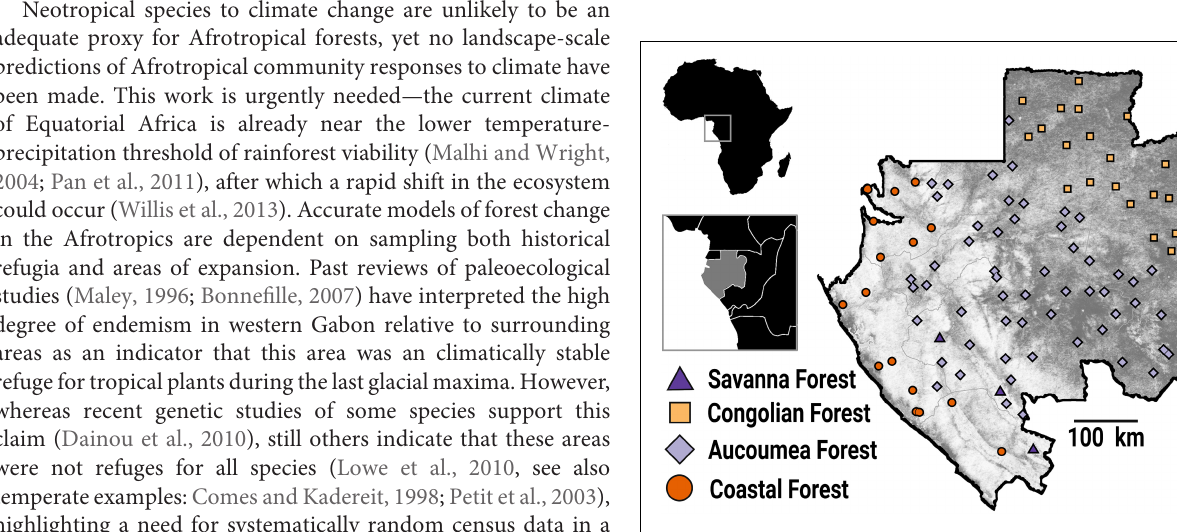
FIGURE 1 | Map of all 104, 1-ha inventory plots located in Gabon. Plots were located by a systematic-random design to capture the full breadth of Gabon’s forest types and environmental conditions. Shapes indicate one of four possible forest-types of each plot: Savanna Forest (triangles), Congolian Forest (squares), Aucoumea Forest (diamonds), or Coastal Forest